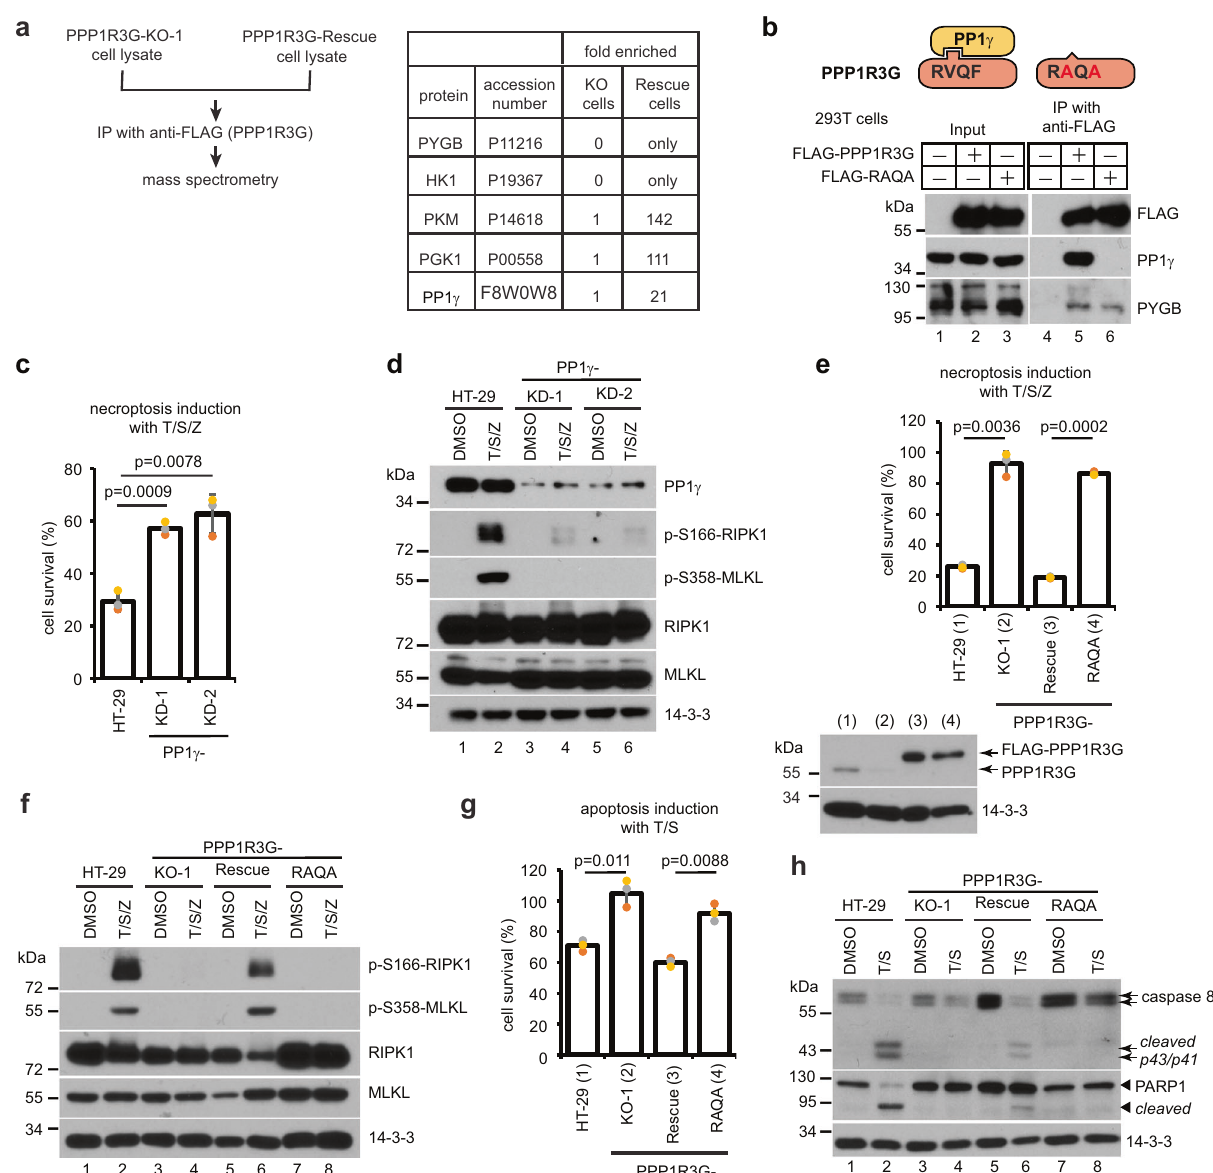
Fig. 3 Interaction with PP1 γ is required for PPP1R3G to activate RIPK1 and cell death. a Lysates from PPP1R3G-KO-1 and PPP1R3G-Rescue cells were subjected to anti-FLAG immunoprecipitation (IP) followed by mass spectrometry analysis. Proteins highly enriched in PPP1R3G-Recue cells were listed. PYGB, glycogen phosphorylase; HK1, hexokinase-1; PKM, pyruvate kinase; PGK1, phosphoglycerate kinase 1. b Upper panel, diagram of the RAQA mutant. Lower panel, anti-FLAG IP result from 293T cells expressing 3xFLAG-PPP1R3G or 3xFLAG-PPP1R3G-RAQA. Western blotting was performed with FLAG, PP1 γ and PYGB antibodies. c PP1 γ was inactivated by CRISPR-Cas9 method in HT-29 cells. These cells were PP1 γ -knockdown (KD) cells because there was residual PP1 γ expression. Cells were treated with T/S/Z for 16 h and cell survival was measured with CellTiter-Glo assay. Viable cells expressed as a percentage of DMSO-treated cells. d Cells were treated with DMSO or T/S/Z for 4 h and Western blotting was performed with the indicated antibodies. e Lentiviruses expressing 3xFLAG-tagged PPP1R3G-RAQA were transduced into the PPP1R3G-KO-1 cells to establish the PPP1R3G-RAQA cell line. Cells were treated with T/S/Z for 16 h and cell survival was measured with CellTiter-Glo assay. Viable cells expressed as a percentage of DMSO-treated cells. Lower panel, Western blotting was performed with PPP1R3G and 14-3-3 antibodies. f Cells were treated with DMSO or T/S/Z for 4 h and Western blotting was performed with the indicated antibodies. g Cells were treated with T/S for 16 h and cell survival was measured with CellTiter-Glo assay. Viable cells expressed as a percentage of DMSO-treated cells. h Cells were treated with DMSO or T/S for 6 h and Western blotting was performed with indicated antibodies. Arrows denote full-length and cleaved caspase 8. Arrowheads denote full-length and cleaved PARP1. CellTiter-Glo results for c , e , and g are represented as mean ± SD of n = 3 biological independent Fig. 4d), suggesting that PPP1R3G acts upstream of caspase 8 results cooperated for the following working model: TNF activation. Indeed, IP with a caspase 8 antibody revealed that treatment induces complex I formation, and co-treatment of caspase 8 did not form complex IIb with FADD or RIPK1 in Smac-mimetic leads to the recruitment of PPP1R3G/PP1 γ to PPP1R3G-KO-1 cells (lane 8, Fig. 4d), con fi rming the essential complex I, which somehow results in RIPK1 kinase activation role of PPP1R3G in complex IIb formation. Taken together, these and subsequent complex IIb formation (Fig. 4e).